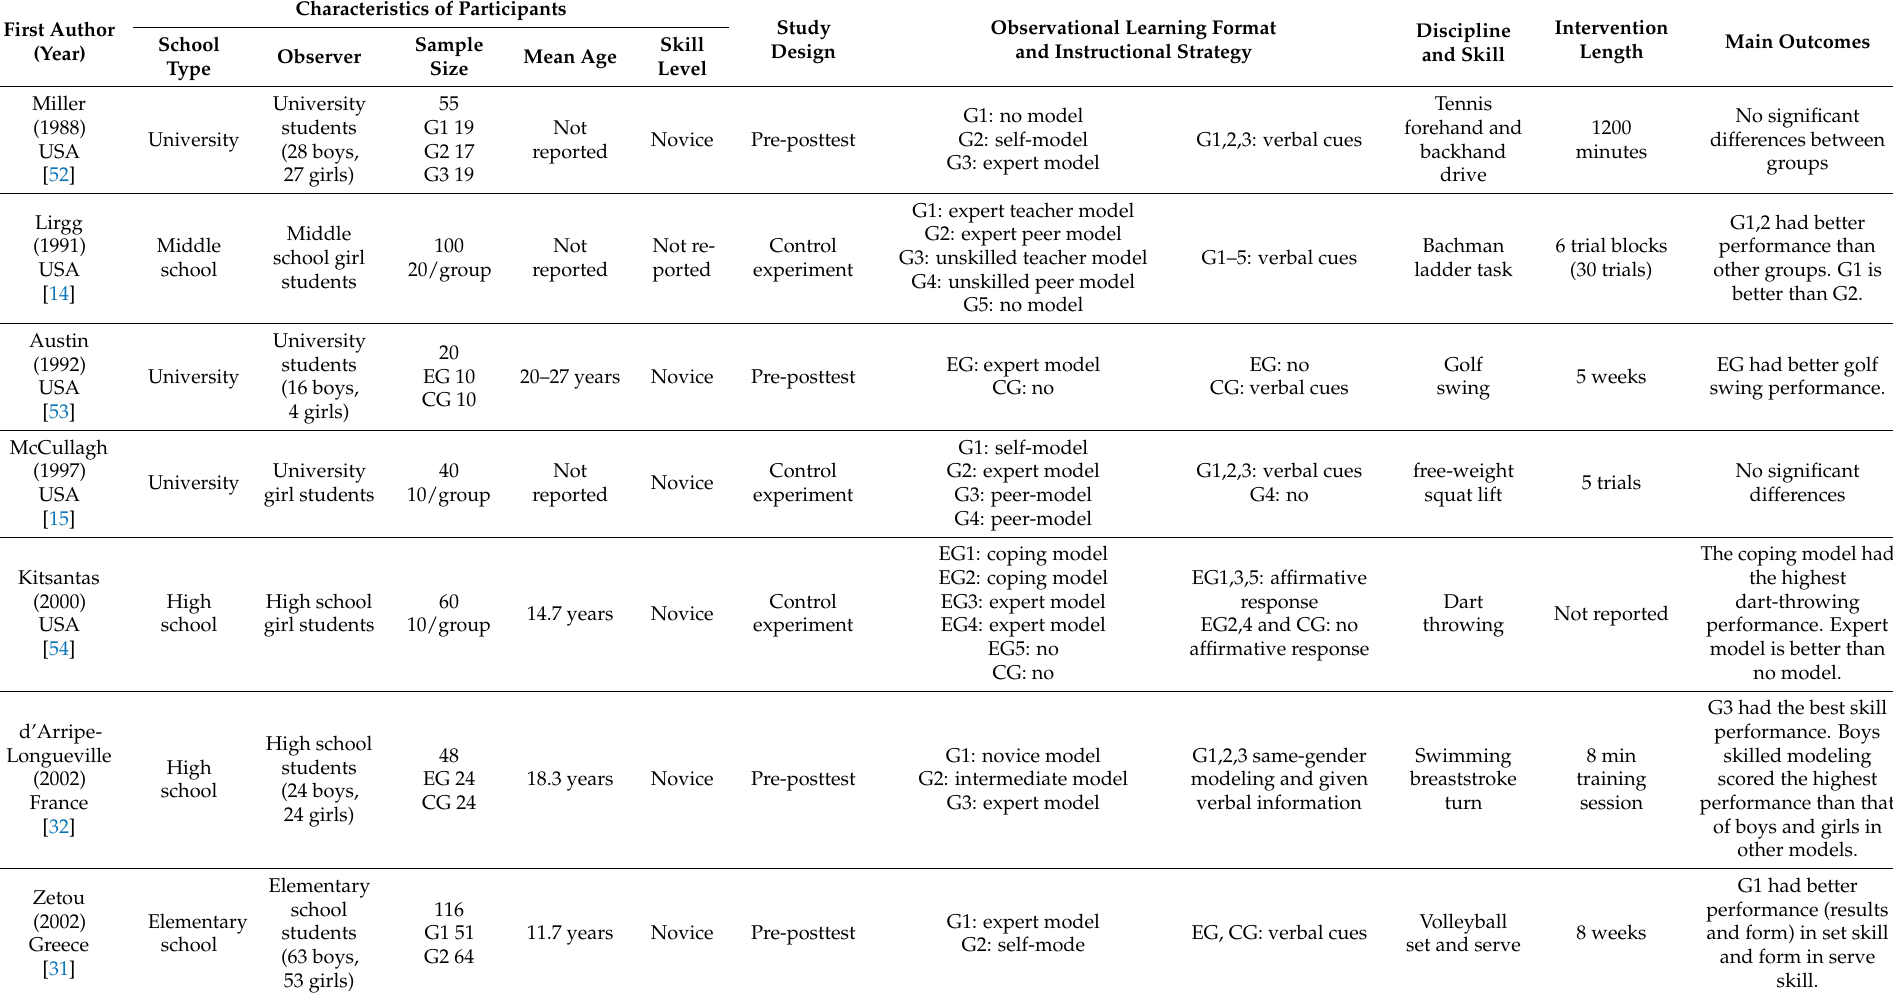
Table 3. Summary Characteristics of Included